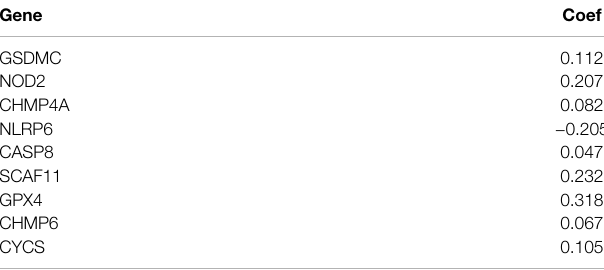
TABLE 2 | The corresponding coef fi cients of 9 PRGs in the risk